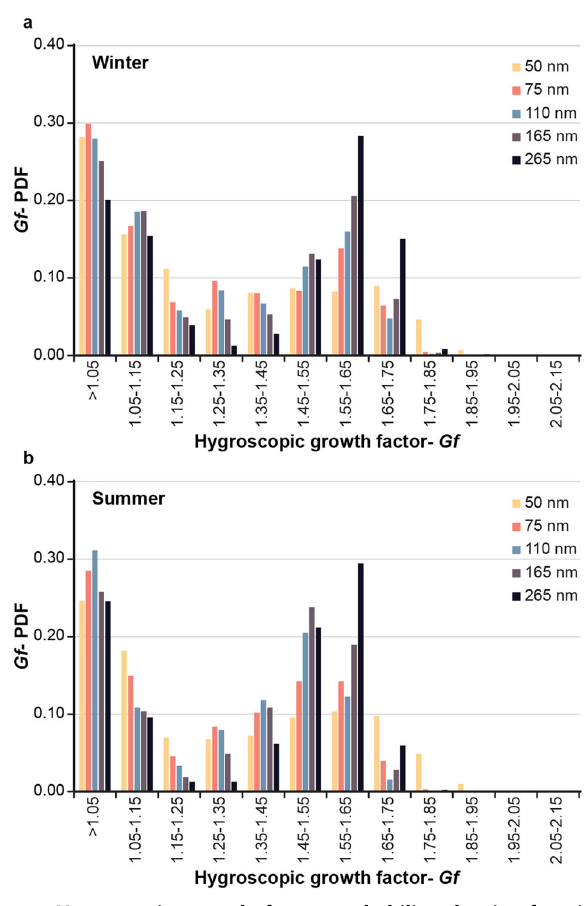
Fig. 1 Hygroscopic growth factor probability density function (Gf-PDF) for particles of 50, 75, 110, 165, and 265 nm. The graphs depict (a) winter, and (b) summer.